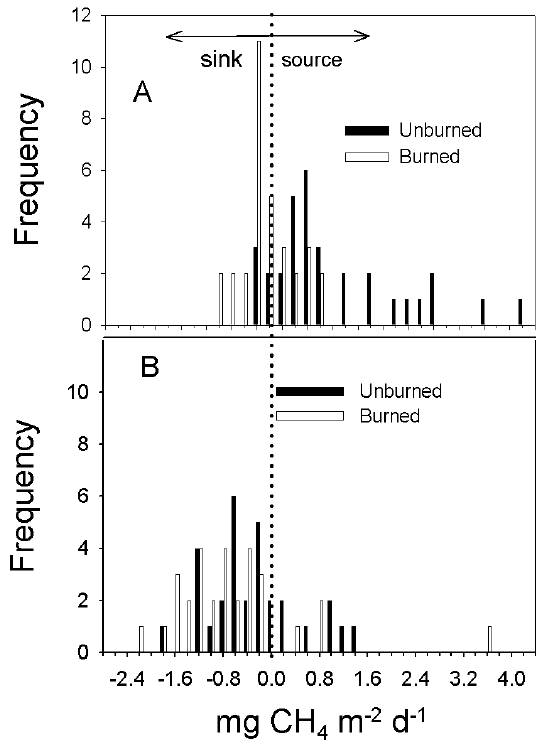
Fig. 4. The frequency distribution of single-chamber estimates of CH 4 fluxes (mgCH 4 m − 2 d − 1 ) measured in unburned and burned plots (no water treatment) during the 1st campaign (A) one month after burning ( n = 32) and the 2nd campaign (B) eight months after burning ( n = 30). The range of each size class interval is 0.2mg CH 4 m − 2 d − 1